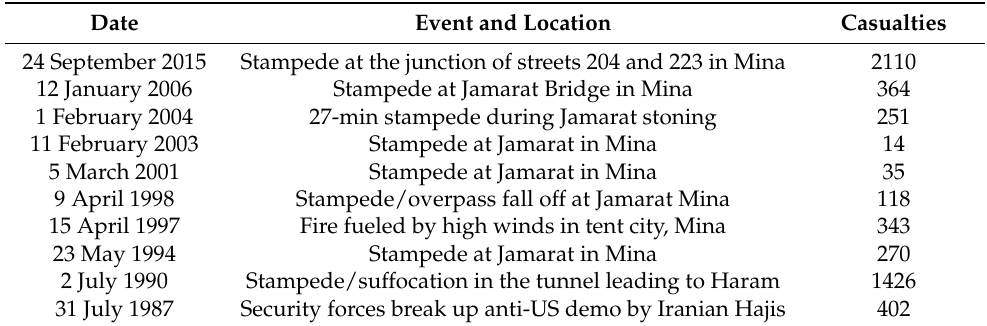
Table 1. Tragic stampedes during Hajj